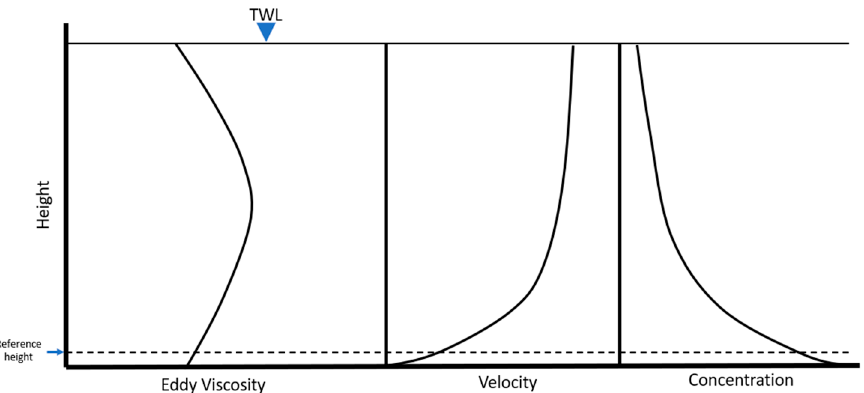
Figure 4. Eddy viscosity, velocity, and concentration distribution profile (Adapted from Liu and Nayamatullah [39]).